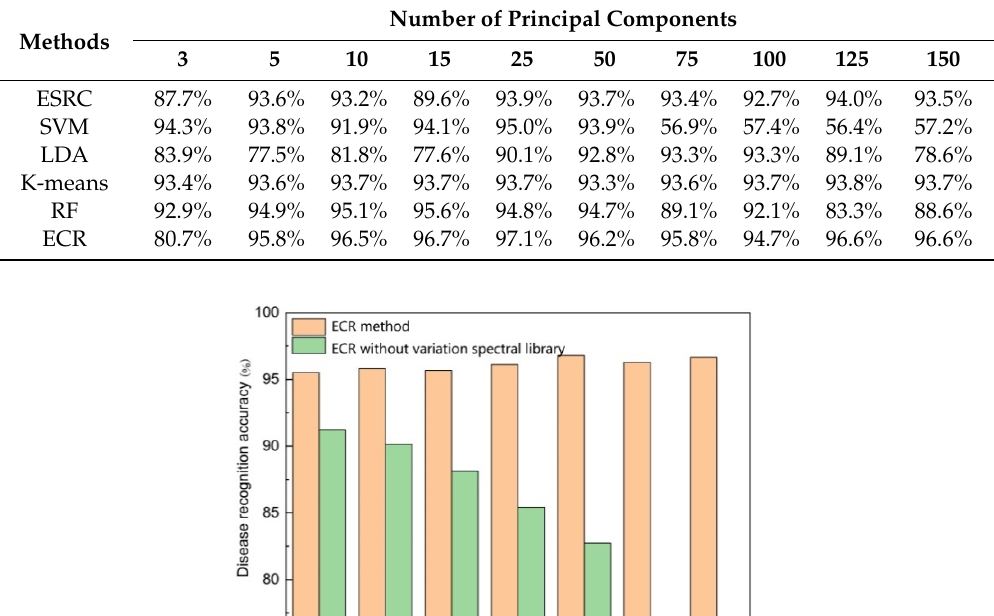
Table 5. Disease recognition accuracies via di ff erent number of principal components.